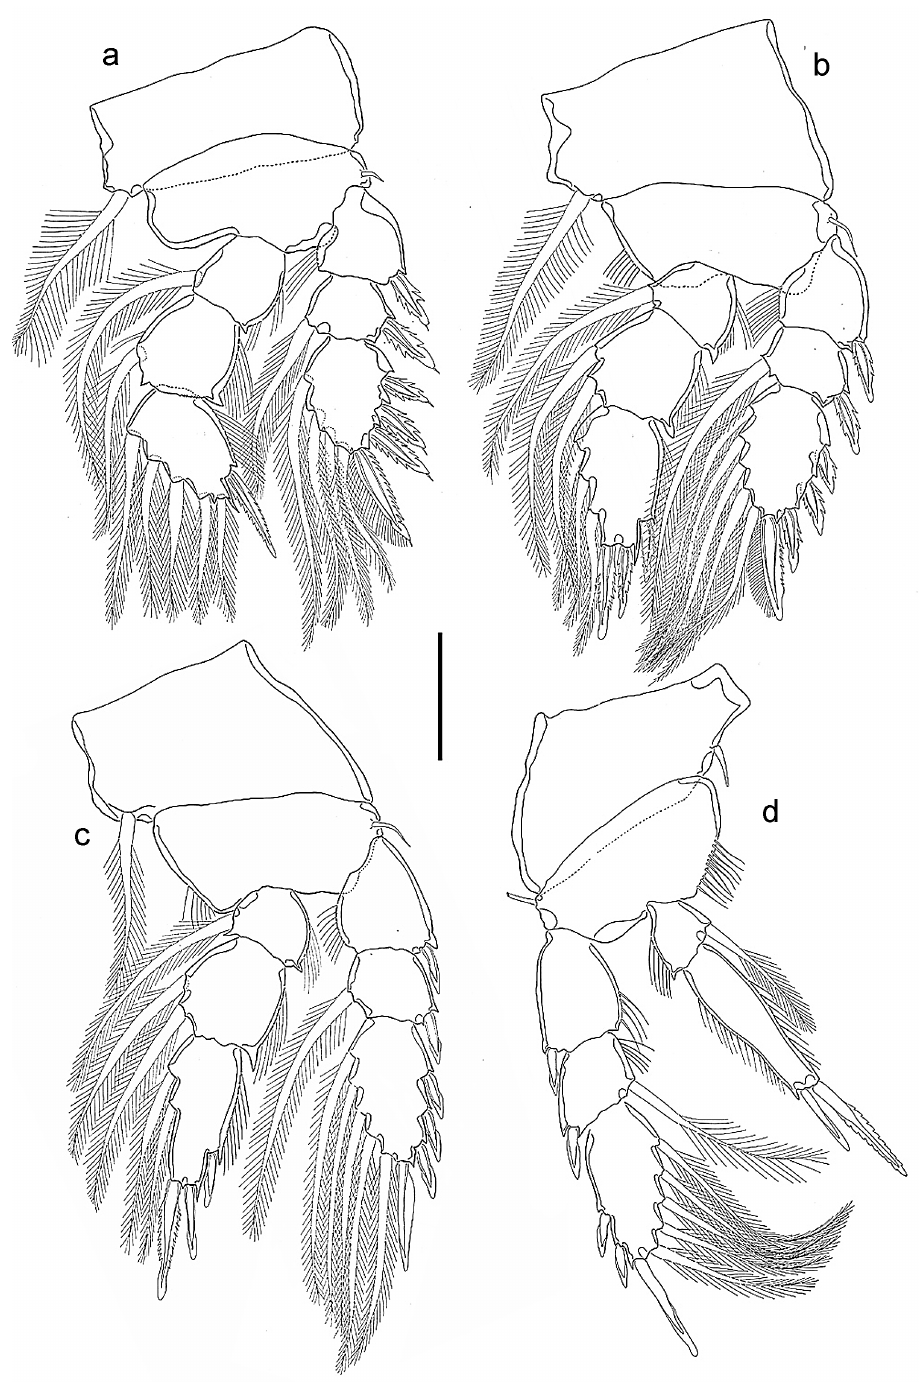
Figure 4. Spaniomolgus globus sp. n., female. a Leg 1 b Leg 2 c Leg 3 d Leg 4 Scale bar: 50